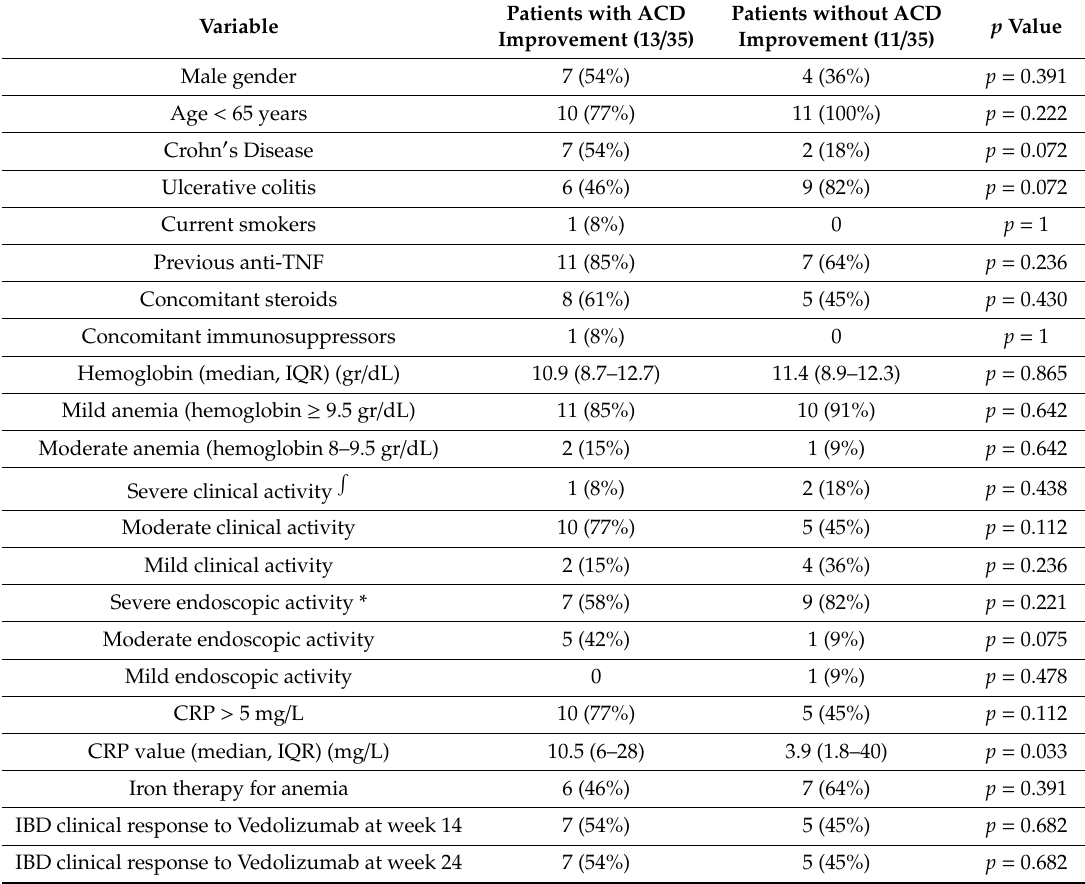
Table 2. Distribution of baseline demographic / clinical characteristics and clinical response to Vedolizumab in patients with ACD improvement and those without ACD improvement. Variable